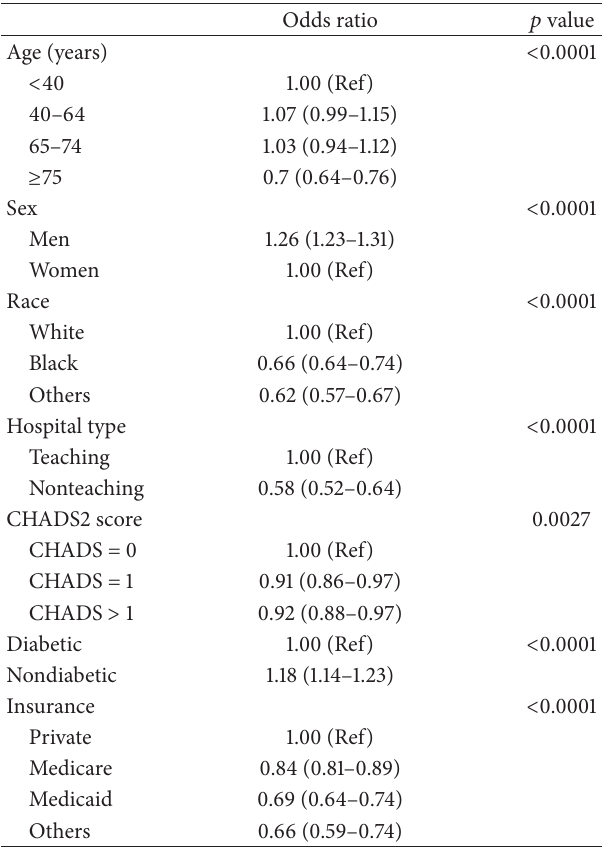
Table 3: Multivariate regression analysis for predictors of cardiover- sion in patients hospitalized for atrial